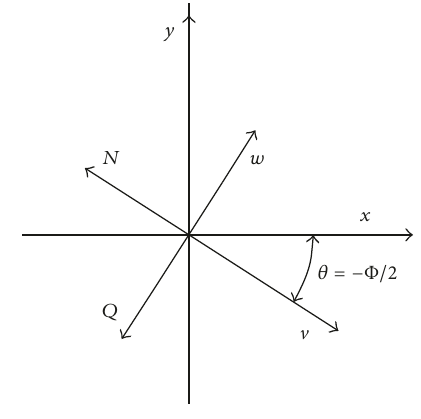
Figure 6: Coordinating relations for the right